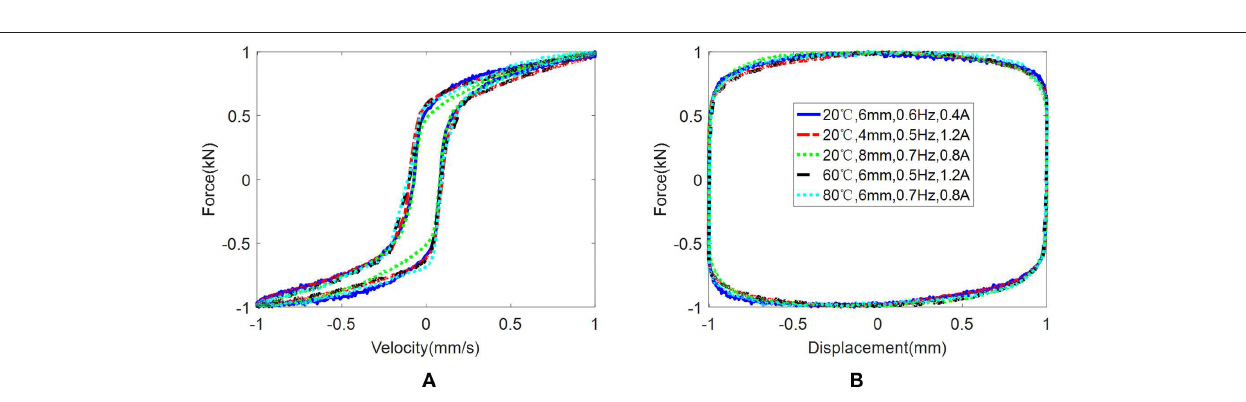
FIGURE 6 | Normalized loops under different conditions: (A) force vs. velocity and (B) force vs. displacement.